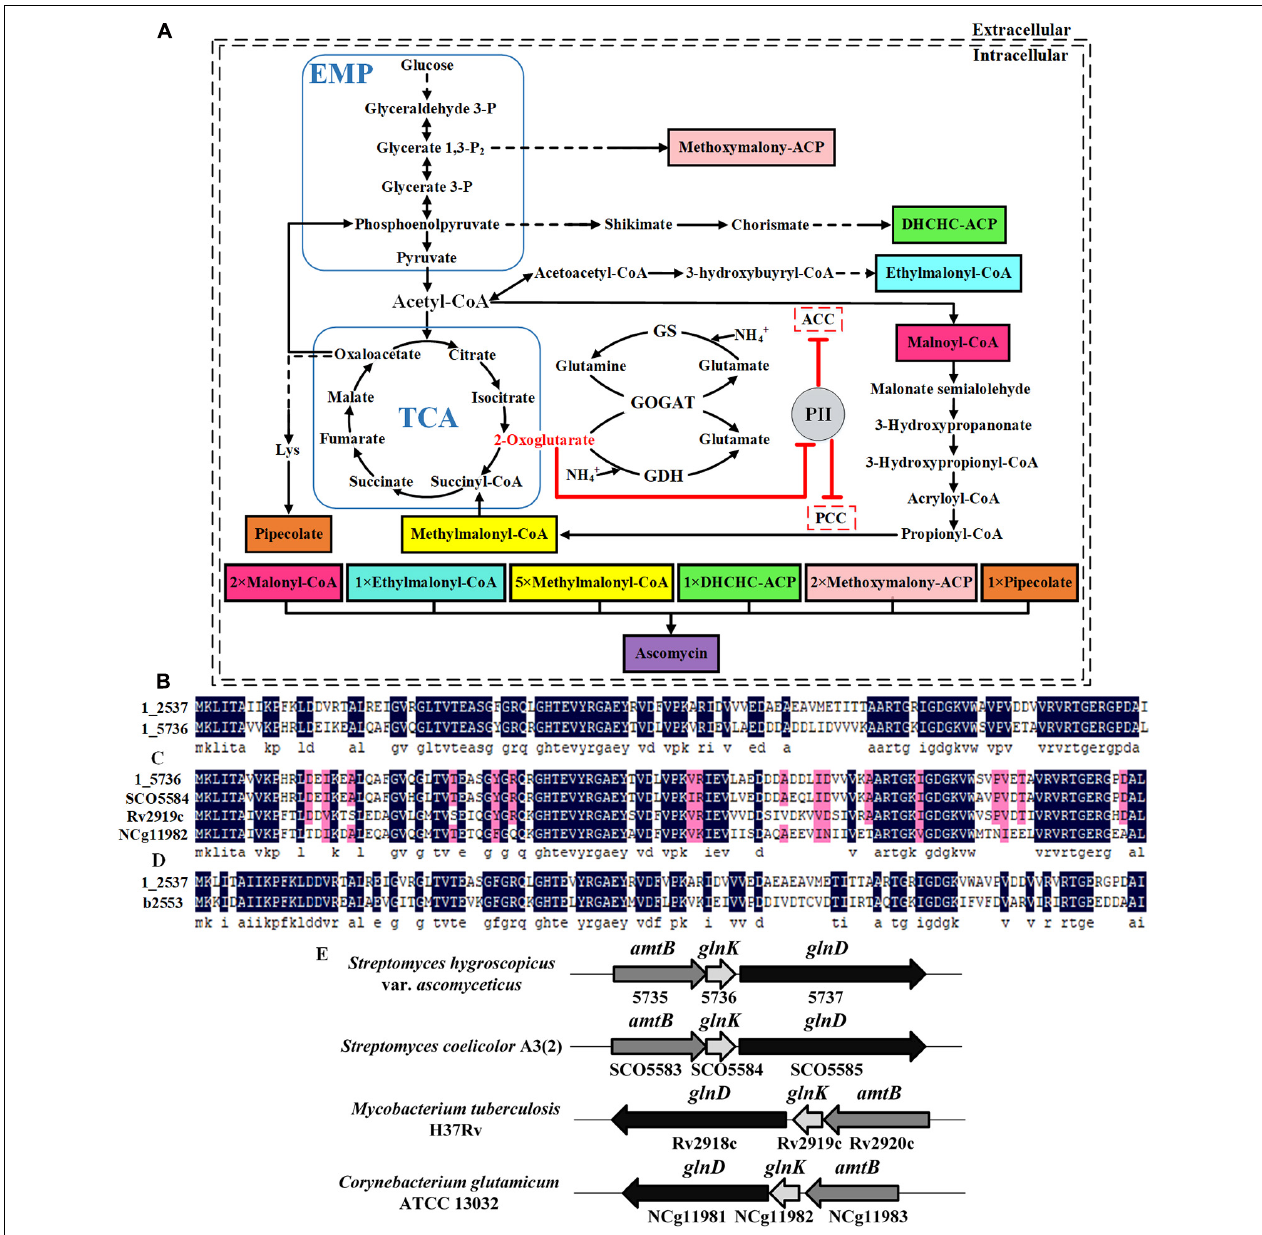
FIGURE 1 | Identification of two PII family signal transduction proteins in Streptomyces hygroscopicus var. ascomyceticus and their influence on the biosynthesis of FK520 precursors. (A) A schematic view of the major primary metabolic pathways for the synthesis of FK520 precursors and the regulation of precursors malonyl-CoA and methylmalonyl-CoA biosynthesis by PII family signal transduction proteins. The solid black lines represent one-step reactions and the dotted black lines represent multi-step reactions. Shaded boxes in different colors represent different precursors of ascomycin. The dotted boxes represent enzymes regulated by the PII family signal transduction proteins. The arrows with flat T ends indicate the inhibitory role. (B) Amino acid sequence alignment of two PII proteins from S. hygroscopicus var. ascomyceticus FS35. The amino acid sequences of these two PII proteins have been uploaded to the GeneBank database (1_2537: MW936359, 1_5736: MW936360). (C) Amino acid sequence alignment between the PII protein encoded by the 1_5736 gene from S. hygroscopicus var. ascomyceticus FS35 and the GlnK proteins from other actinobacteria. SCO5584 represents the GlnK protein from Streptomyces coelicolor A3(2), which is retrieved from the NCBI database (TYP02429.1). Rv2919c represents the GlnK protein from Mycobacterium tuberculosis H37Rv, which is retrieved from the NCBI database (AFN50901.1). NCg11982 represents the GlnK protein from Corynebacterium glutamicum ATCC13032, which is retrieved from the NCBI database (BAB99453.1). (D) Amino acid sequence alignment between the PII protein encoded by the 1_2537 gene from S. hygroscopicus var. ascomyceticus FS35and the GlnB protein of Escherichia coli K-12. The amino acid sequence of the GlnB protein in E. coli K-12 was retrieved from the NCBI database (AAC75606.1). All the sequence alignments were performed using DNAMAN (Version6). The dark blue shadows highlight the identical residues and the residues with more than 75% sequence similarity are shaded in pink. (E) Arrangement of the amtB-glnK-glnD operon in different actinobacteria. The shaded arrow boxes represent different genes and the direction of each arrow represents the direction of transcription. The length of boxes is proportional to the length of each gene sequence.